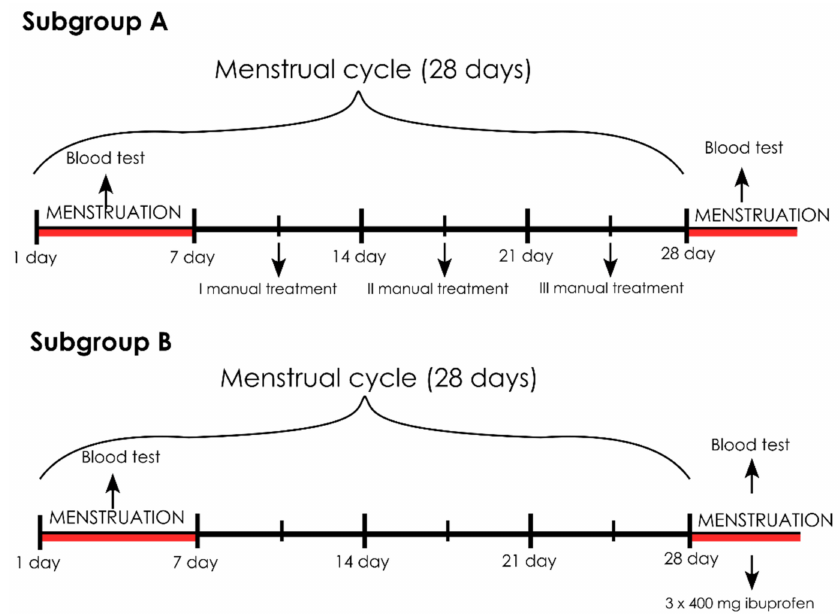
Figure 2. The scheme for carrying out the therapy in subgroups A and